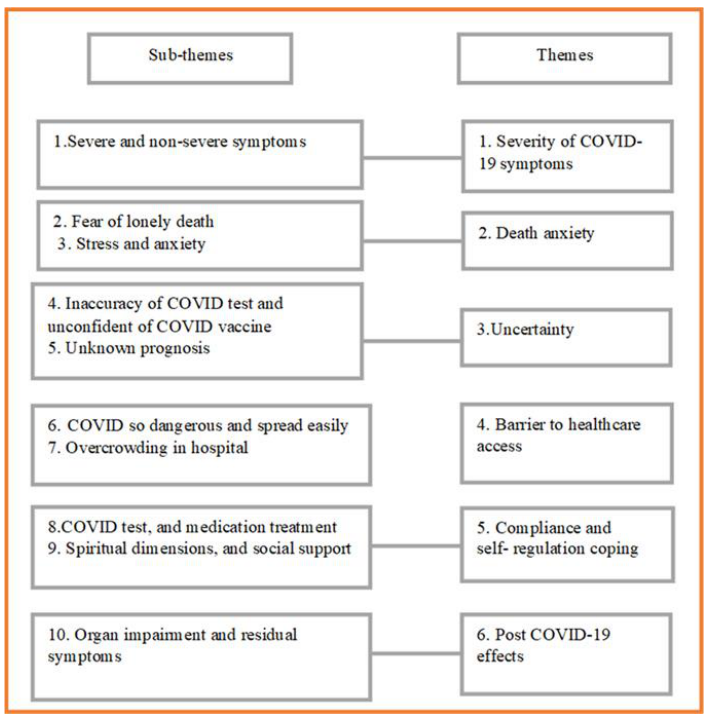
Figure 1. Themes and subthemes: physical, psychological distress, and coping among people infected with COVID-19.